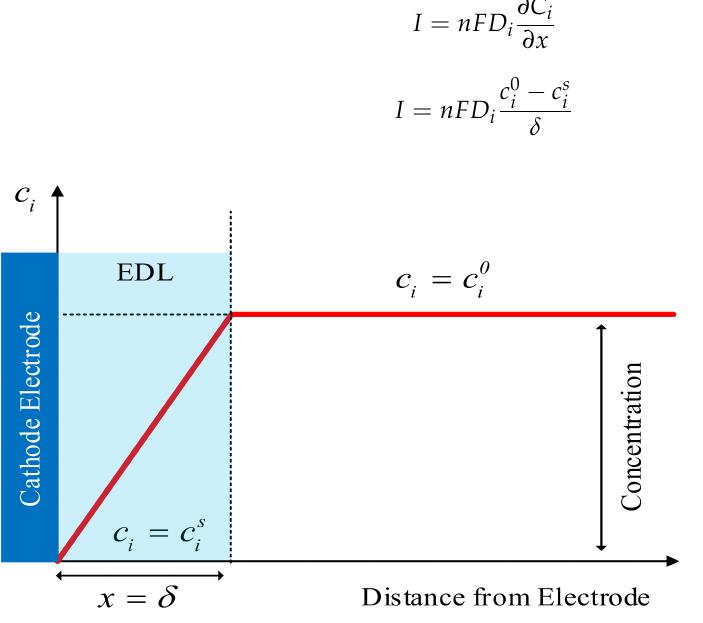
Figure 6. Concentration gradients of internal chemical species in the water